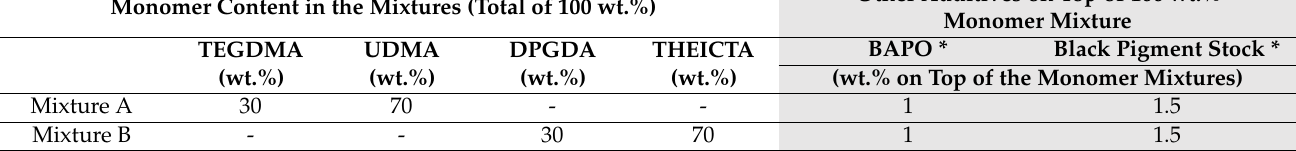
Table 2. The compositions of Mixtures A and B. Monomer Content in the Mixtures (Total of 100